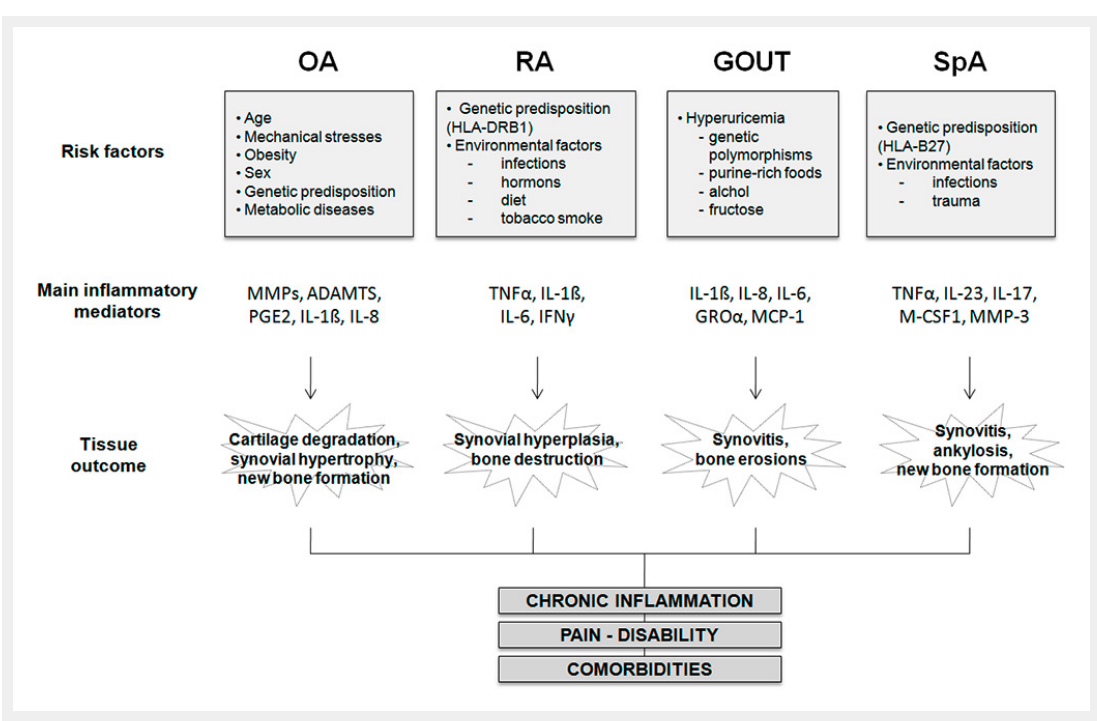
Figure 1 Schematic pathogenesis of most common arthropathies. Several risk factors are implicated in the development of osteoarthritis, rheumatoid arthritis, gout and spondyloarthritis. Each of these diseases is characterised by the release of specific inflammatory mediators which mainly lead to joint destruction, pain, disability, chronic inflammation and co-morbidities. ADAMTS = a disintegrin and metalloproteinase with thrombospondin motifs; GRO = growth regulated oncogene; HLA = human leucocyte antigen; IFN = interferon; IL = interleukin; M-CSF = macrophage colony-stimulating factor; MMPs = metalloproteinases; OA = osteoarthritis; PGE = prostaglandin E; RA = rheumatoid arthritis; RANKL = Receptor activator of nuclear factor kappa-B ligand; SpA = spondyloarthritis; TNF = tumour necrosis